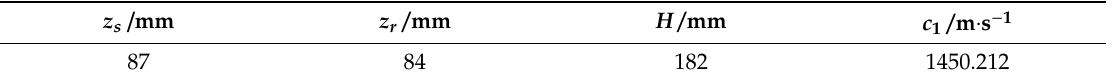
Table 3. The measurement parameters of the anechoic tank experiment.